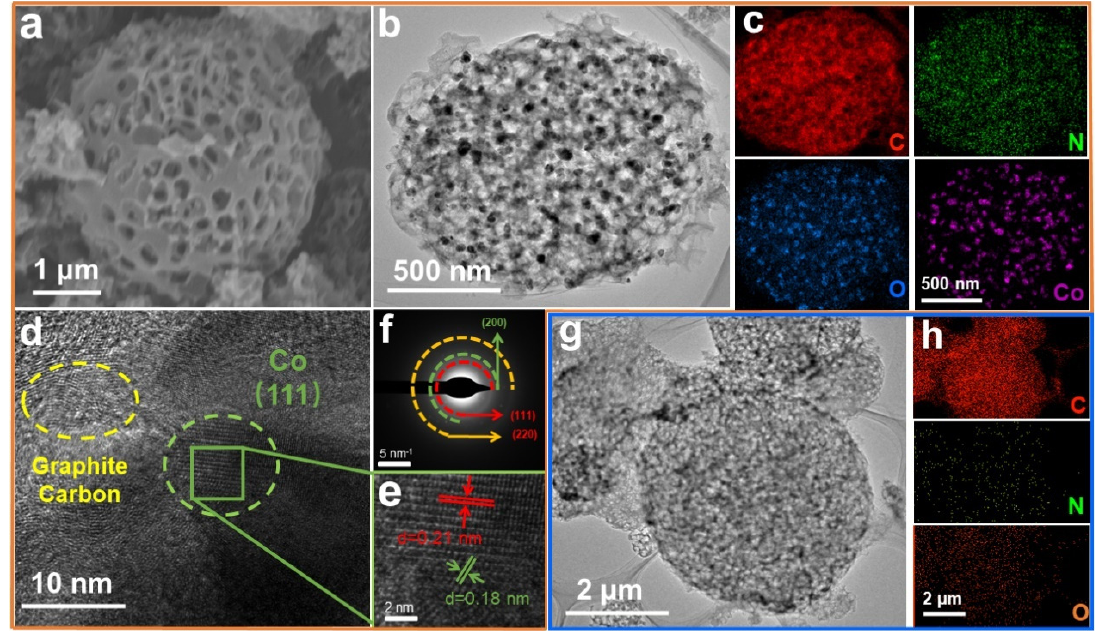
Figure 2. ( a ) SEM and ( b ) TEM image, ( c ) corresponding C, N, O, Co elemental mapping and ( d – f ) HRTEM image and SEAD of Co/N-PCSs. ( g ) TEM image and ( h ) C, N, O elemental mapping of N-PCSs.